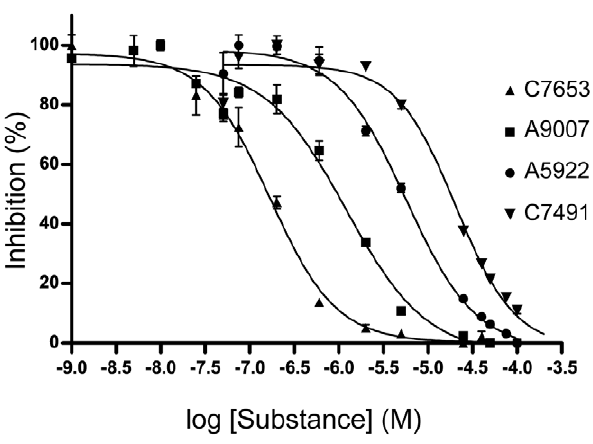
Figure 2. Dose-response curves for a subset of hits. In the figure, the mean 6 standard deviation of 2–4 determinations is plotted.